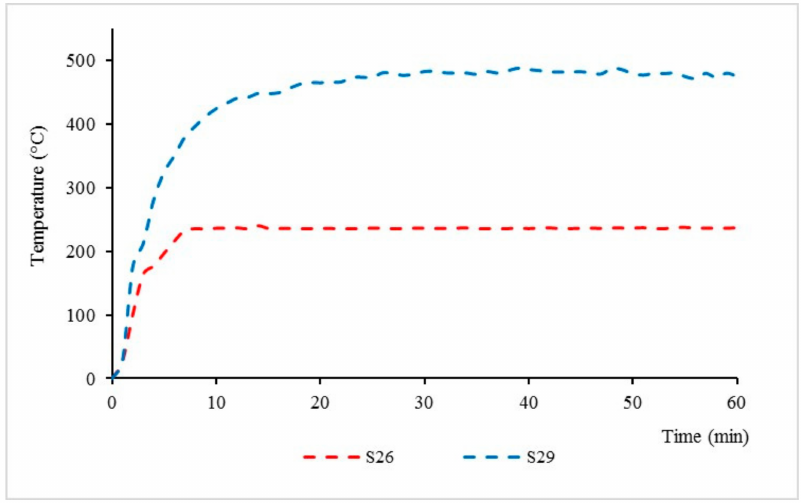
Figure 6. S26 and S29 fire resistance test